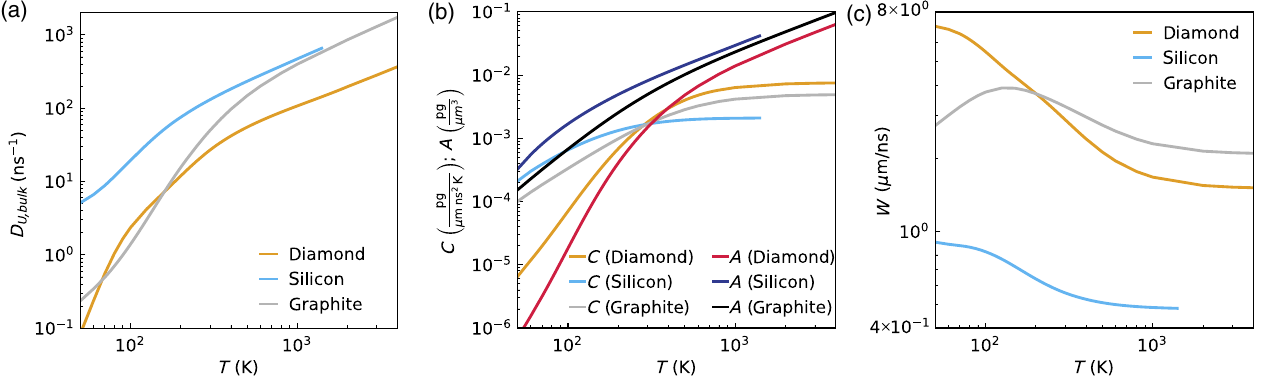
FIG. 8. Trends as a function of the temperature of various quantities reported in Tables I – III. (a) Values of the bulk momentum